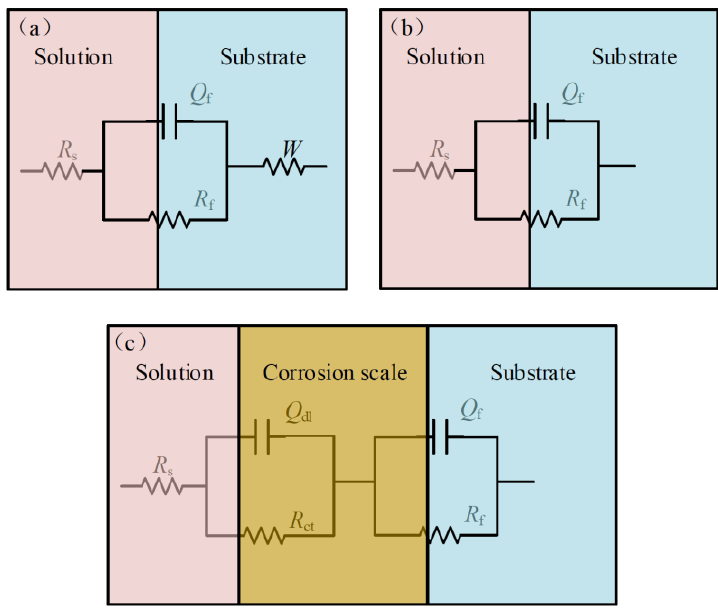
Figure 4. Equivalent circuits. ( a ) The equivalent circuit for 0, 1 and 4 days, ( b ) the equivalent circuit for 10, 17 and 24 days, and ( c ) the equivalent circuit for 31 days. ( W represents Warburg impedance, R ct represents polarization resistance, R s represents the electrolyte resistance, R f and Q f represent the resistance and capacitance of the titanium alloy matrix, and Q dl represents the constant phase angle element of the outer layer of the oxide film.)